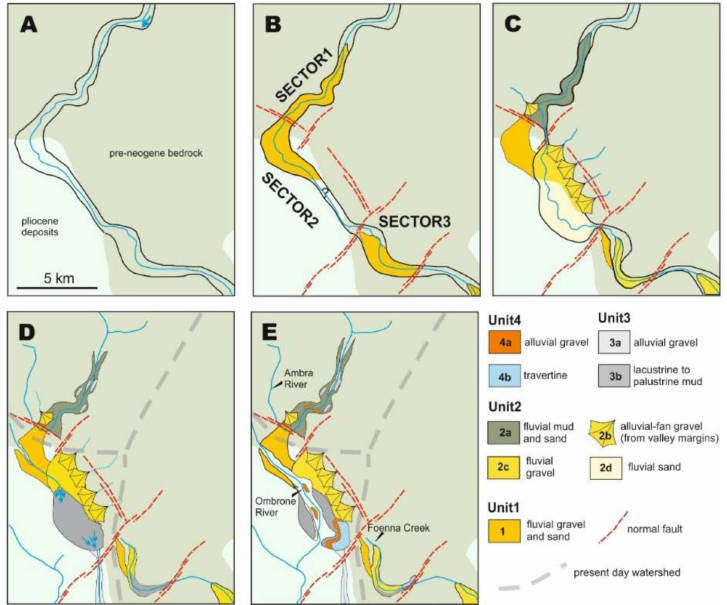
Figure 17. Reconstructed depositional evolution of the study